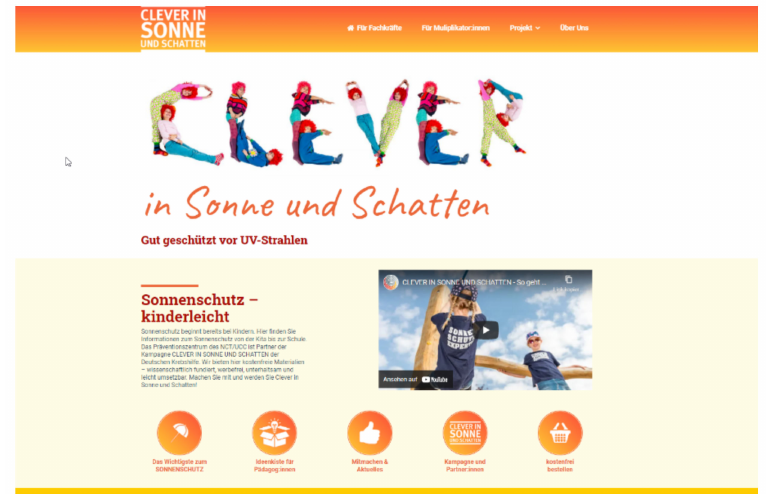
Figure 11. Program website www.cleverinsonne.de © NCT/UCC 2021 (accessed on 27 July